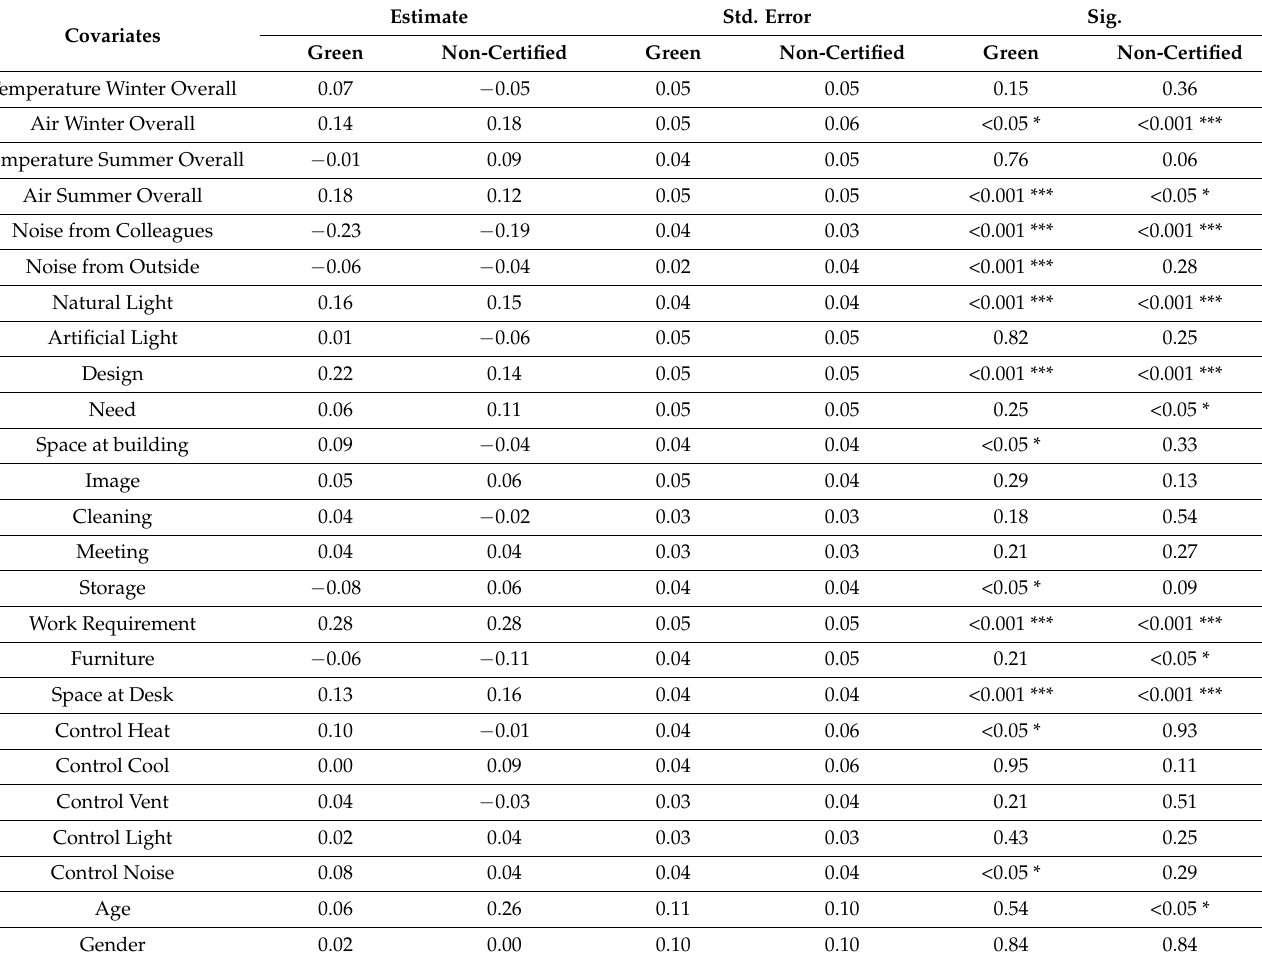
Table 10. Ordinal regression of perceived productivity comparing green and non-certified buildings. Estimate Std. Error Sig. Covariates Green Non-Certified Green Non-Certified Green